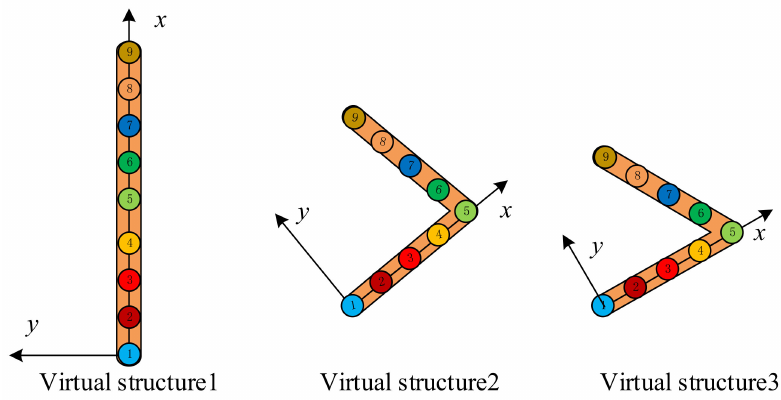
Figure 27. ( a ) Real and desired attitude of the virtual linkage; ( b ) error between real and desired